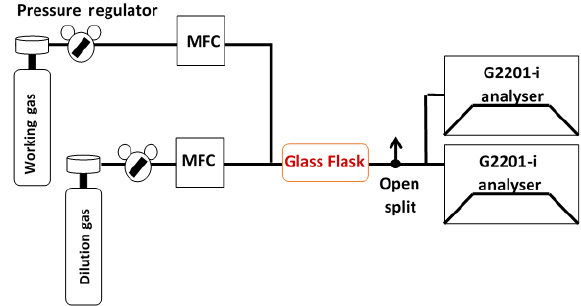
Figure 2. General set-up. The dilution and working gas are con- nected via two MFCs to two CRDS instruments in parallel. In red is the placement of an optional glass flask used for the C 2 H 6 cali- bration only. The flow is greater than that of the instruments’ inlets. Therefore an open split is included to vent additional gas and retain ambient pressure at the